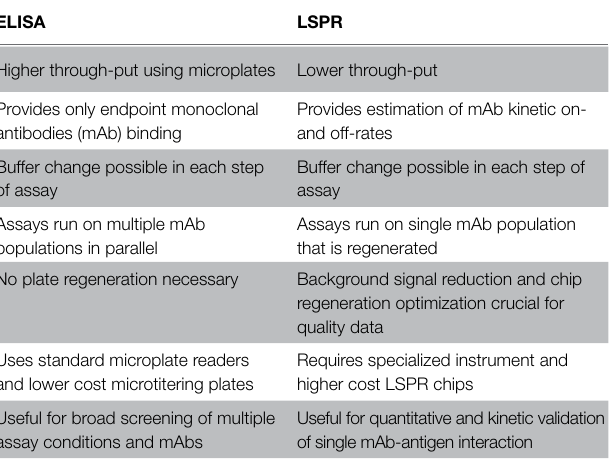
TABLE 1 | Comparison of advantages and disadvantages of ELISA vs. localized surface plasmon resonance (LSPR) technology. ELISA